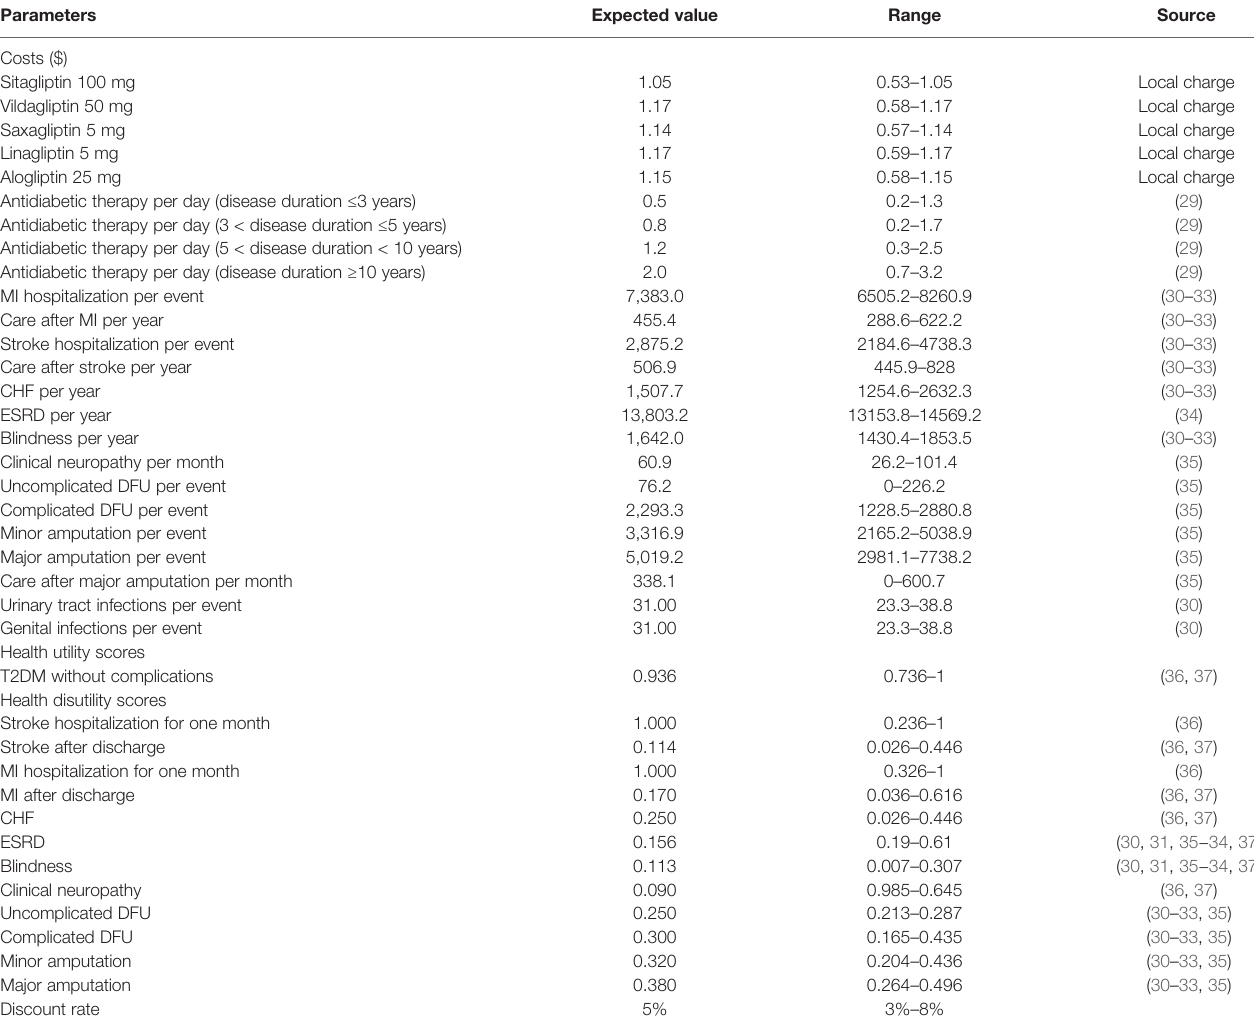
TABLE 1 | Key model inputs of costs and